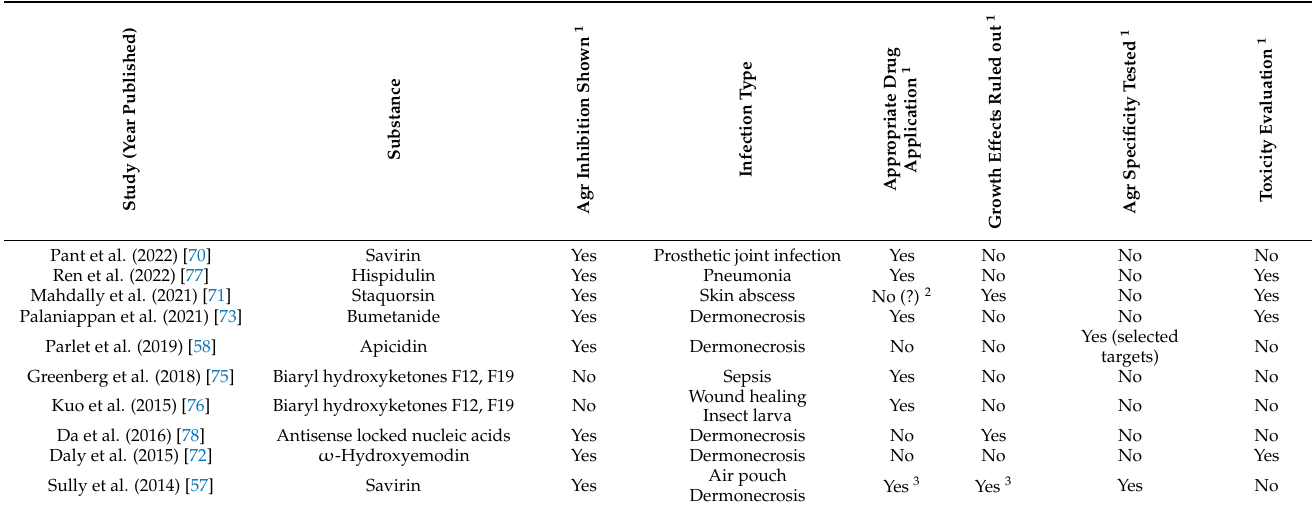
Table 2. In vivo studies with drugs targeting